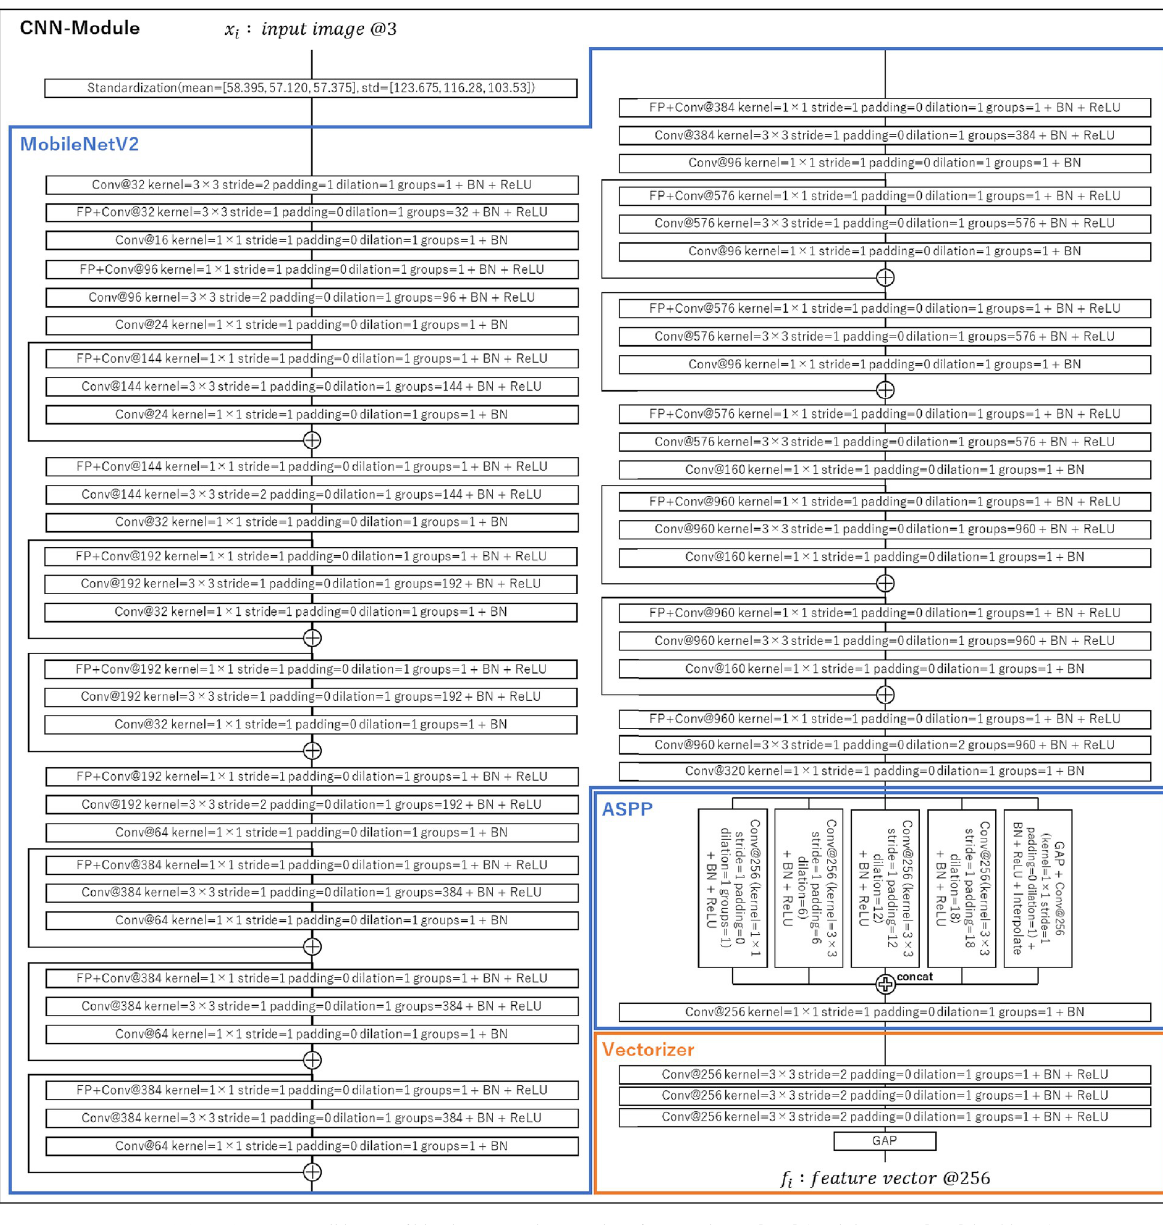
Fig 4. Our CNN-Module architecture. All layers of blue boxes are the encoder of DeepLab v3+ [113] (MobileNetV2 [115]-backbone). Vectorizer is a CNN+GAP layer that we added to convert feature maps to vectors. Each layer component corresponds to the class diagram in Fig 3. Hyper- parameters not listed use the default values from Fig